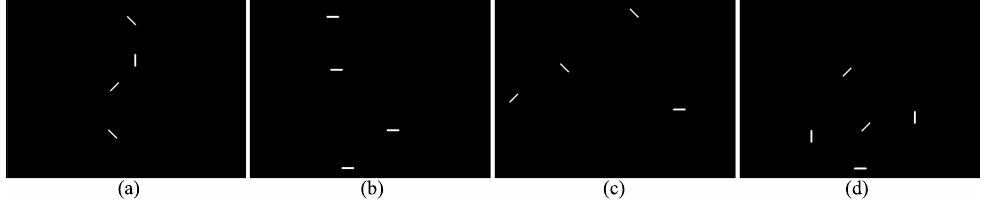
Figure 7. The selected fish swarm patterns in the study are illustrated: ( a ) Fish Schooling-Following, ( b ) Fish Schooling-Parallel, ( c ) Shoal, and ( d ) Fish Schooling-Tornado patterns. The GoPro camera collected and labeled 1200 images according to fish swarm